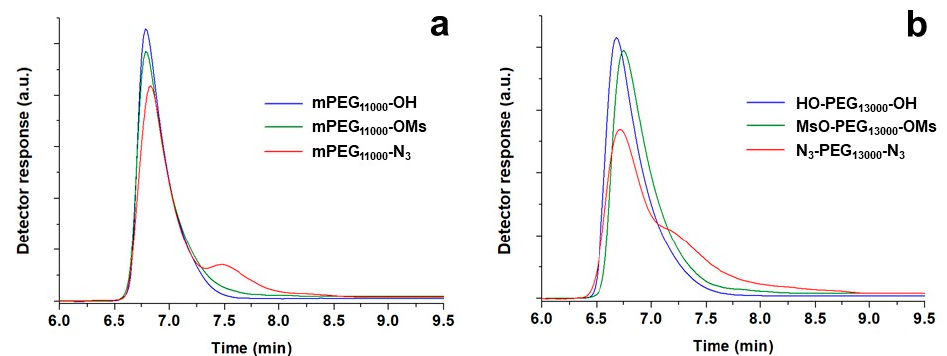
Figure 4. Normalized SEC curves of mPEG 11000 ( a ) and PEG 13000 ( b ) series.